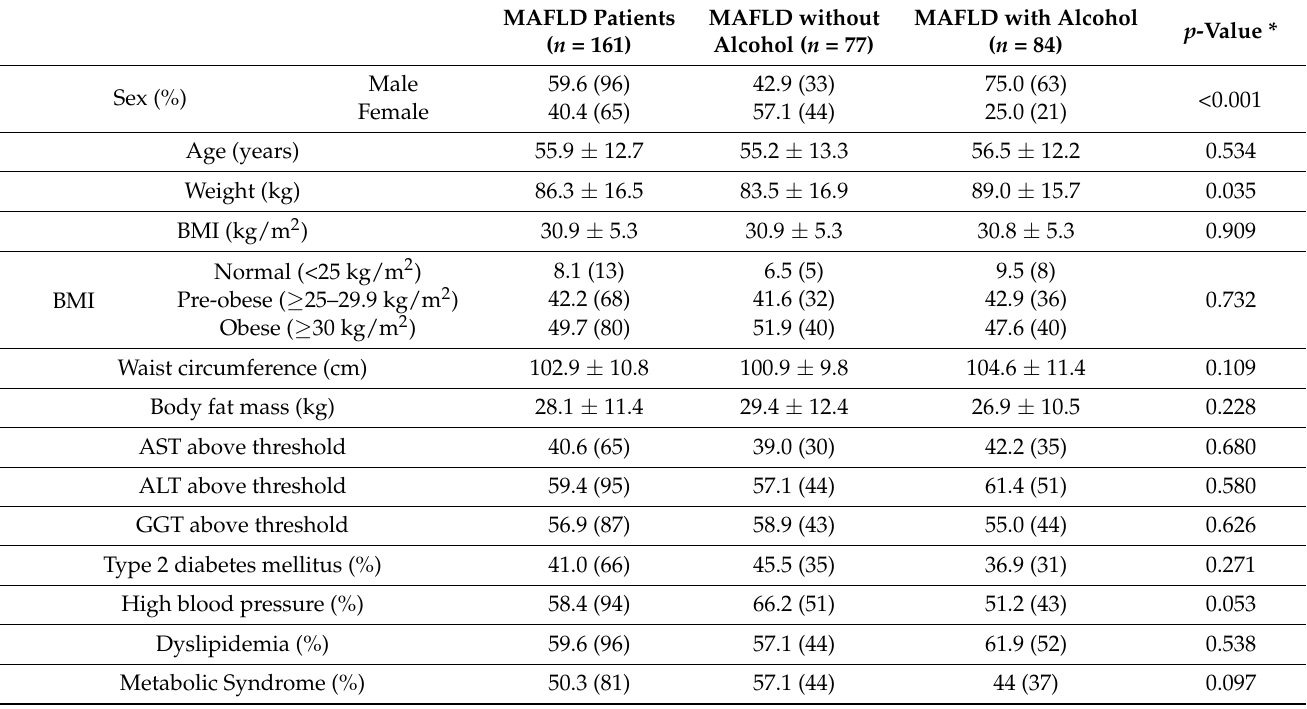
Table 1. Baseline patient characteristics.